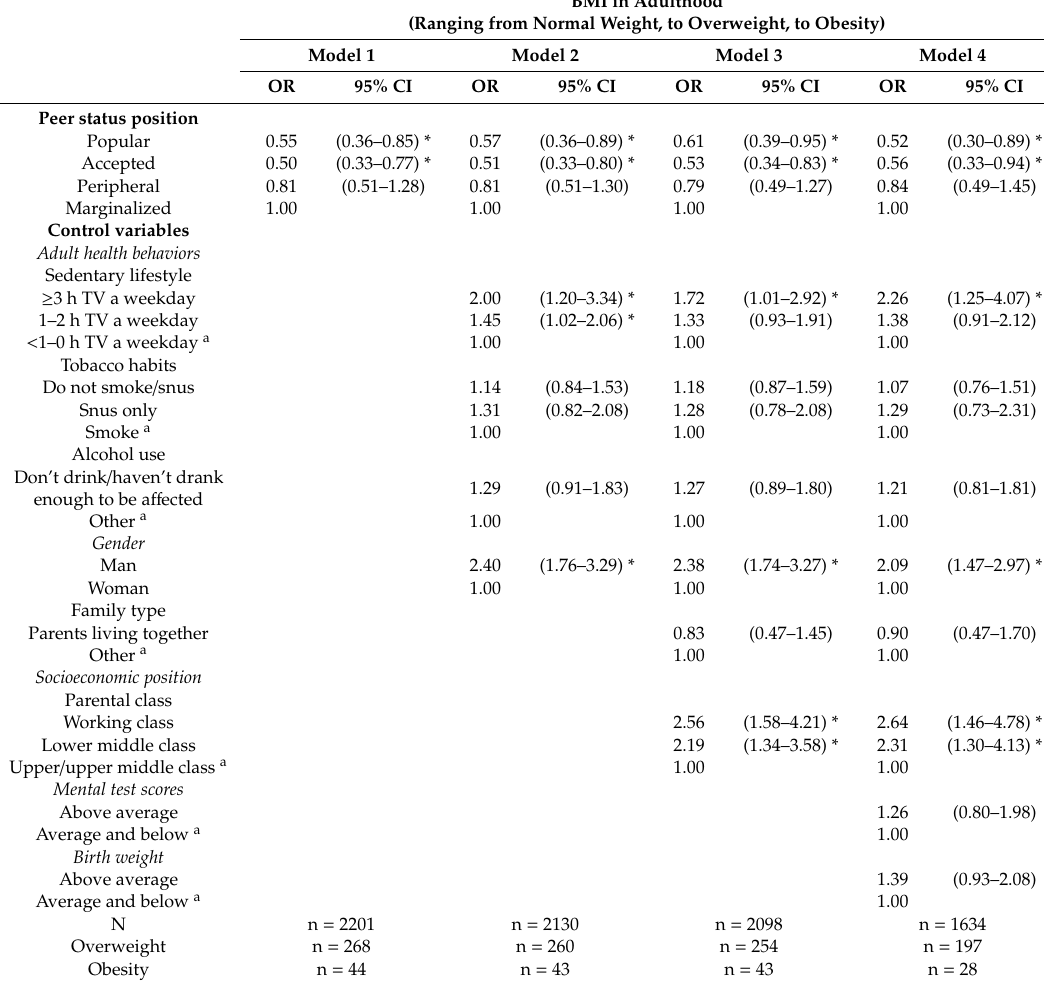
Table 1. Generalized ordered logistic regressions of BMI in adulthood and peer status position in childhood, Sweden, 1953–1983. Adjusted Odds Ratios (OR) with 95% confidence intervals (CIs). BMI in Adulthood (Ranging from Normal Weight, to Overweight, to